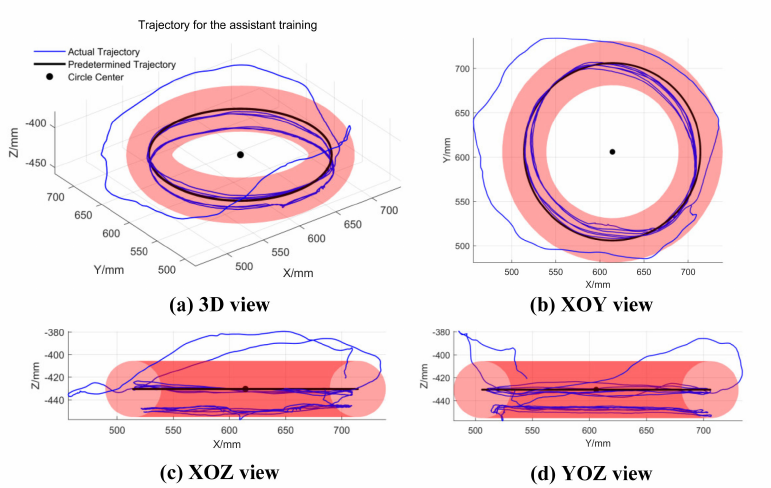
Figure 14. The trajectory of the subject’s hand during the assistant testing. ( a ) A 3D view of the trajectory; ( b – d ) XOY, XOZ, and YOZ view of the trajectory, respectively.